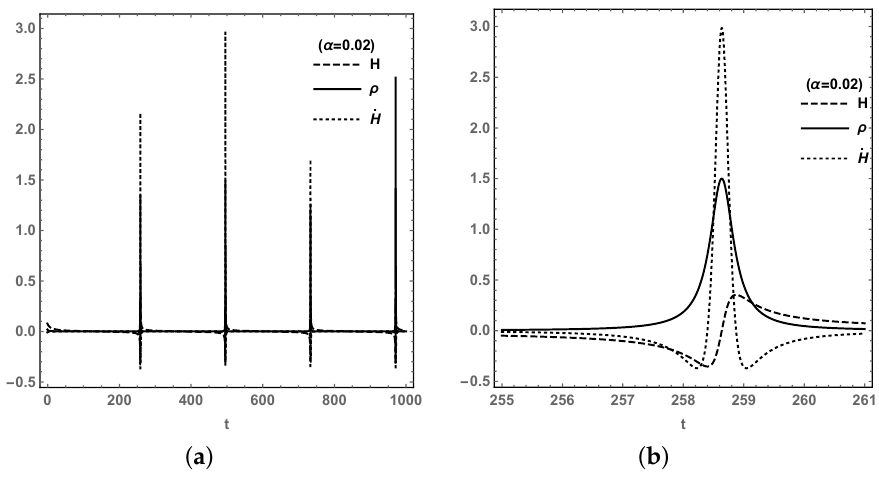
Figure 7. ( a ) The evolutions of H , ˙ H and ρ in LQC around P 3 , by the initial condition of φ 0 = 9, ˙ φ = 0.9, H = 0.07 and ρ = 0.015; ( b ) The local figure in ( a ) of t ∈ [ 255,260 ] where bouncing 0 0 0